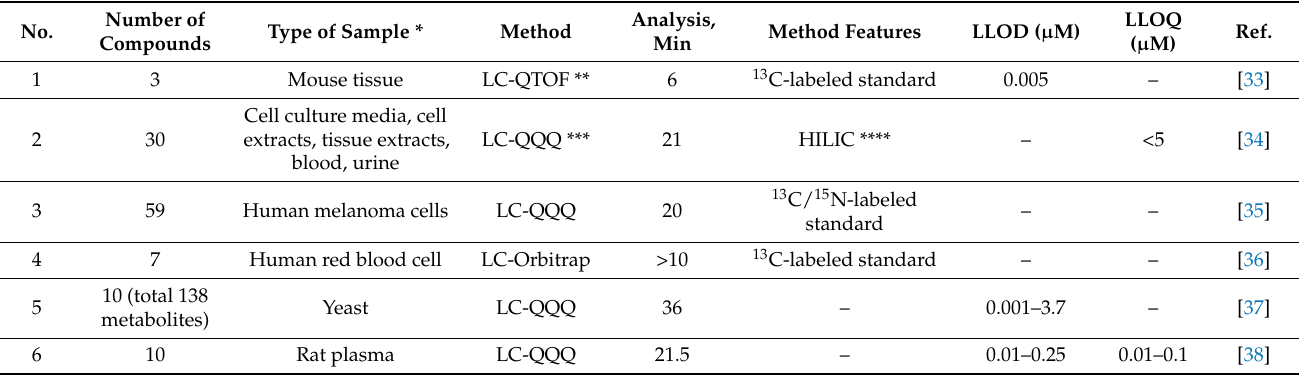
Table 2. Comparative analysis of HPCL-MS/MS approaches for quantitative detection of carboxylic acids in blood